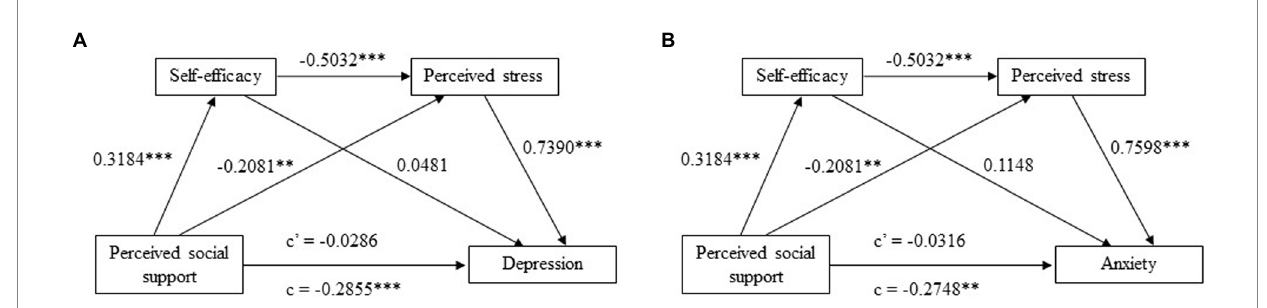
FIGURE 2 The chain mediation model with standardized path coefficients. **, p < 0.01; ***, p < 0.001; c, total effect; c’, direct effect. (A) The chain mediating effect of self-efficacy and perceived stress between perceived social support and depression; (B) The chain mediating effect of self-efficacy and perceived stress between perceived social support and